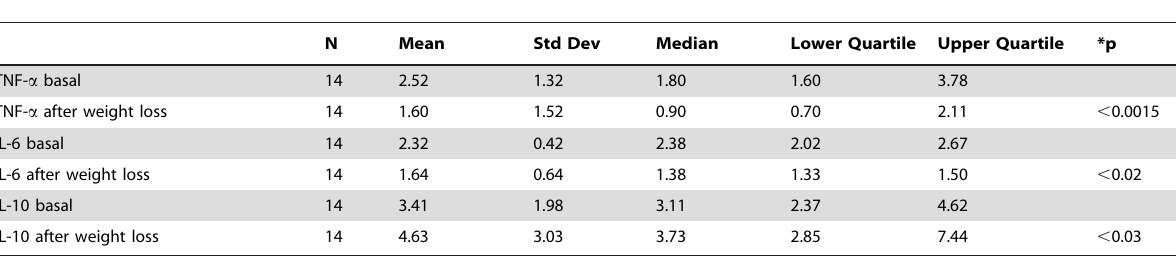
Table 3. Inflammatory parameters of study